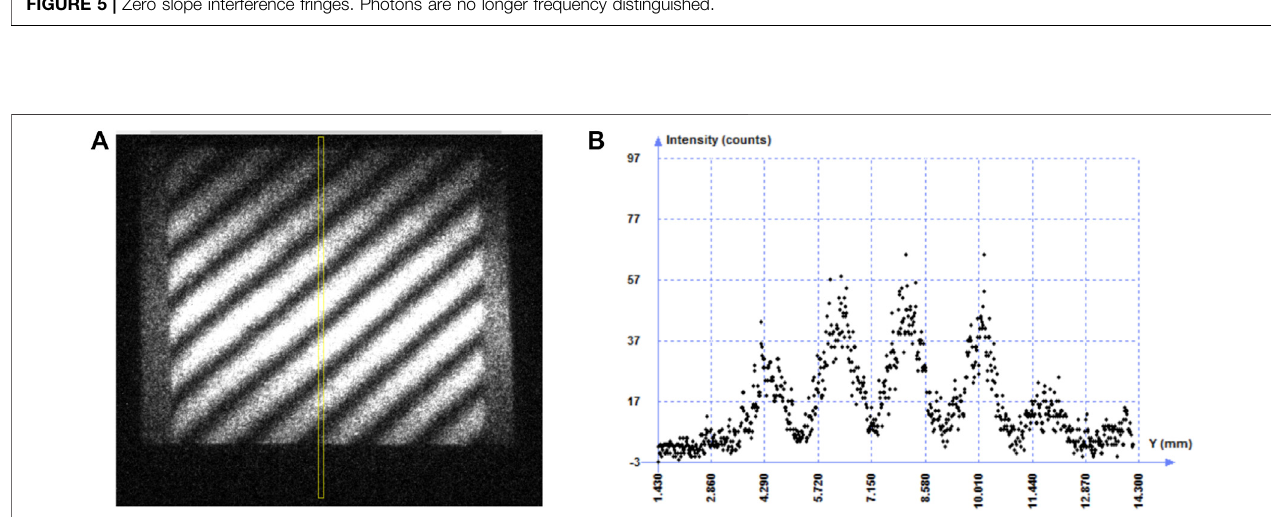
FIGURE6| Regionofinterferogramshownin Figure4 ,limitedtosmallrangein t butthewholerangein y . (A) Rectanglewidthis0.7 ns(widthisoversizedinimage for clarity), height encompasses the entire y range; (B) Plot of spatial pro fi le averaged over △ t (cid:1) 0.7 ns (Optoanalyze v3.71).